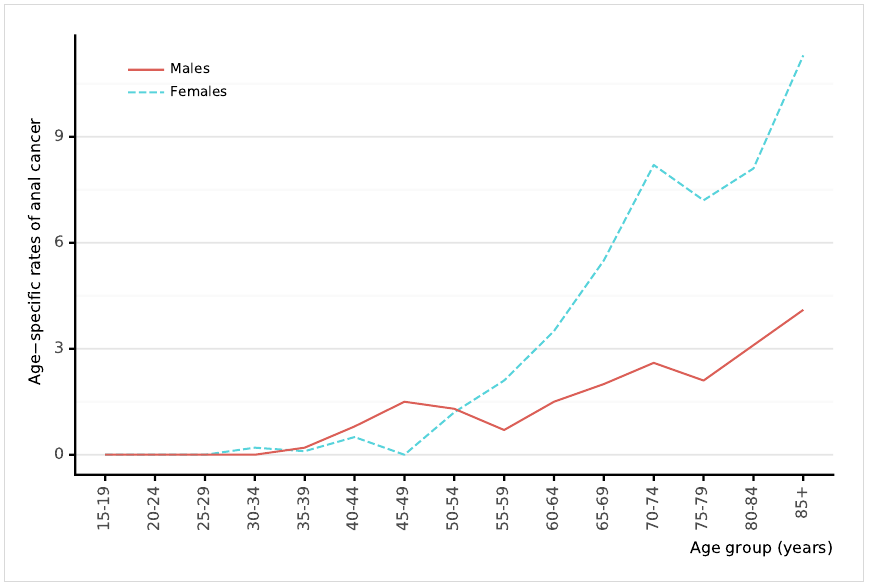
Figure 15: Age-specific incidence rates of anal cancer in Peru (estimates for 2020)